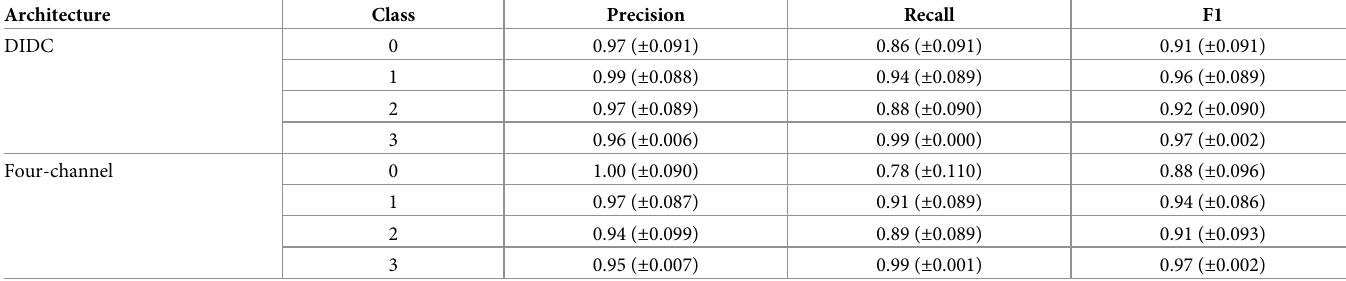
Table 5. DIDC and four-channel comparison. Class 0 to 3 indicates the patient either has normal thyroid (0), has malignant left-side thyroid (1), has right-side thyroid malignant (2), or has both sides malignant (3).